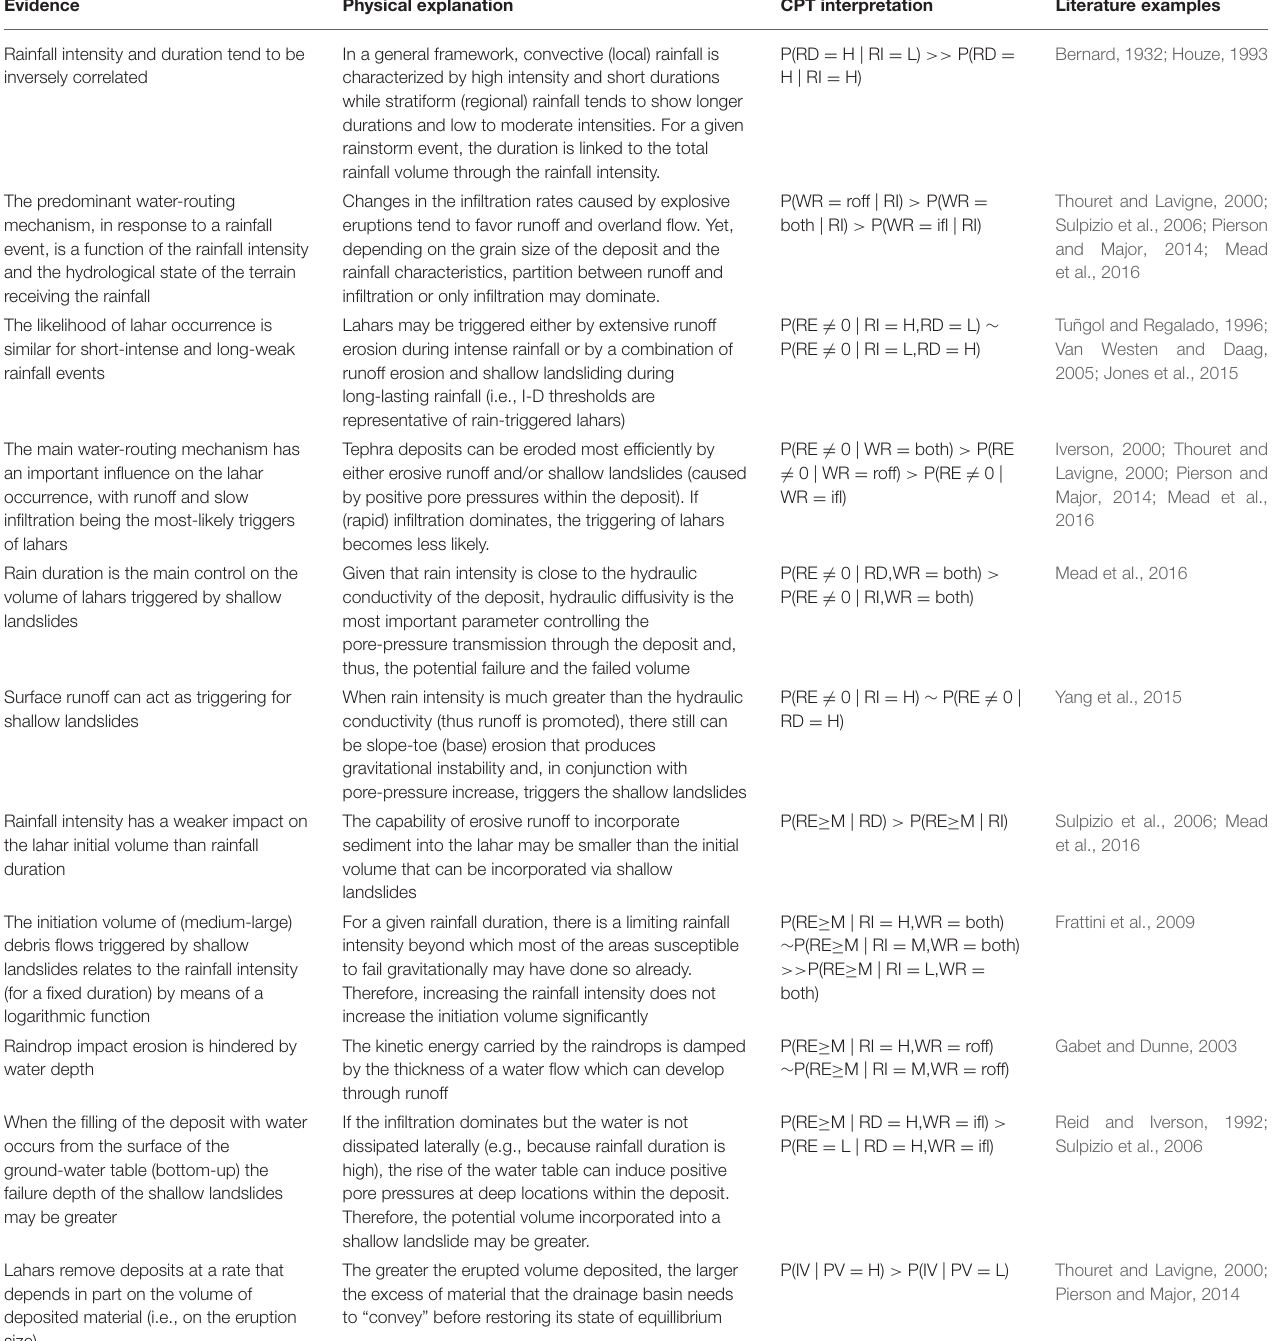
TABLE 2 | Summary of all the strands of evidence (first column), and their physical explanation (second column), collected from literature related to rain-triggered of lahars.